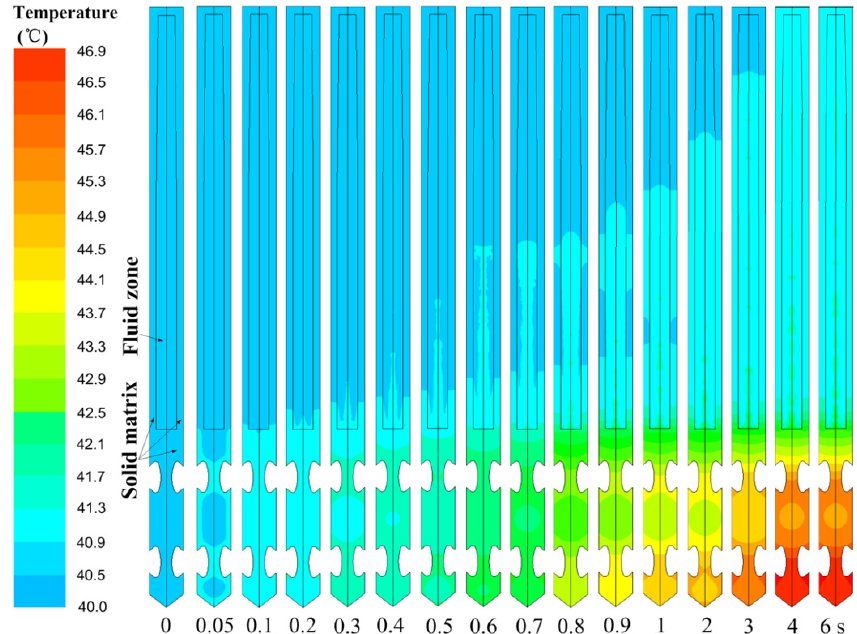
Figure 8. Temperature contours in the RHPD at different time.